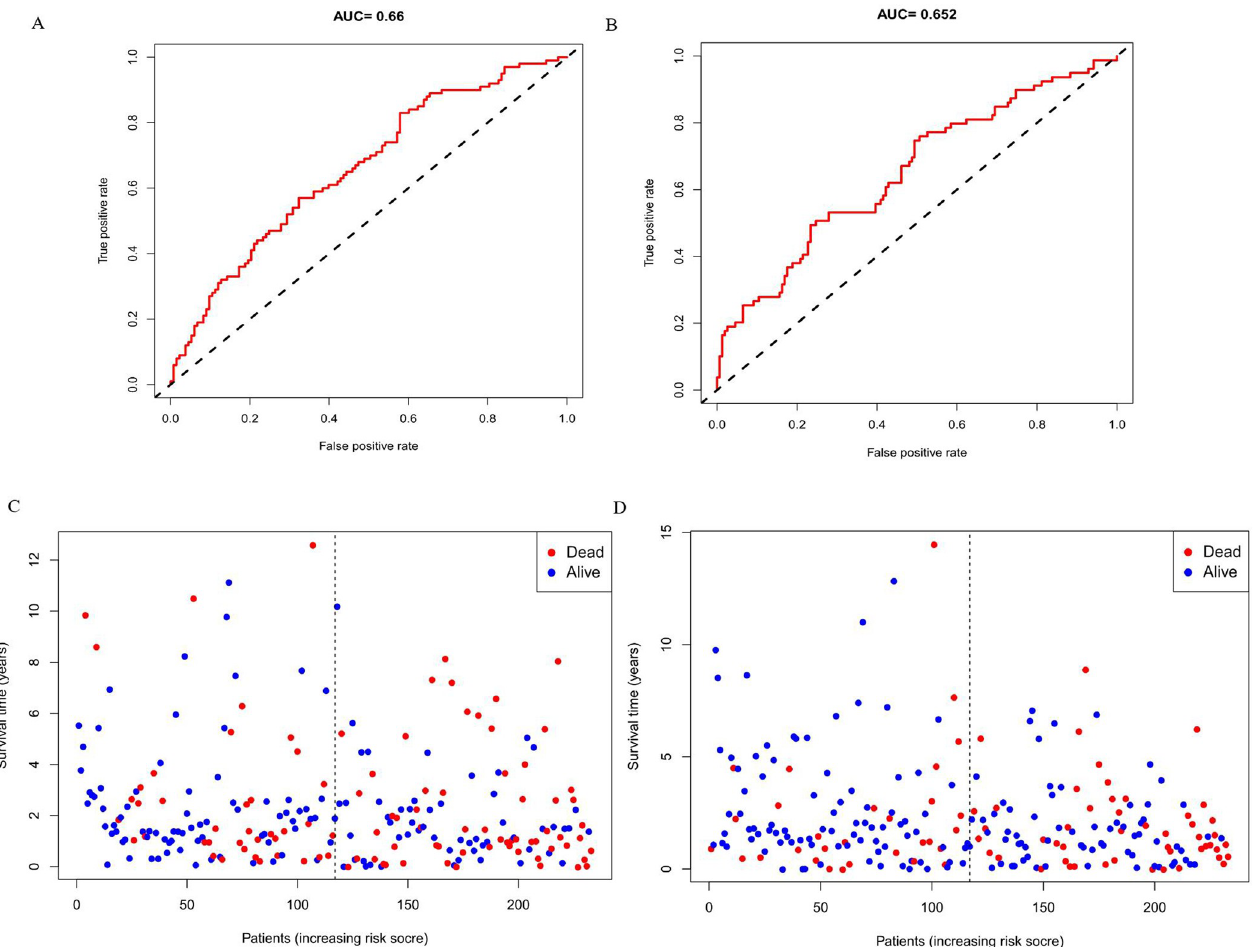
Fig 5. ROC curves and risk survival status of patients in the training set and testing set. A: ROC in training set; B: ROC in testing set; C: Survival status in the training set; D: Survival status in testing set.